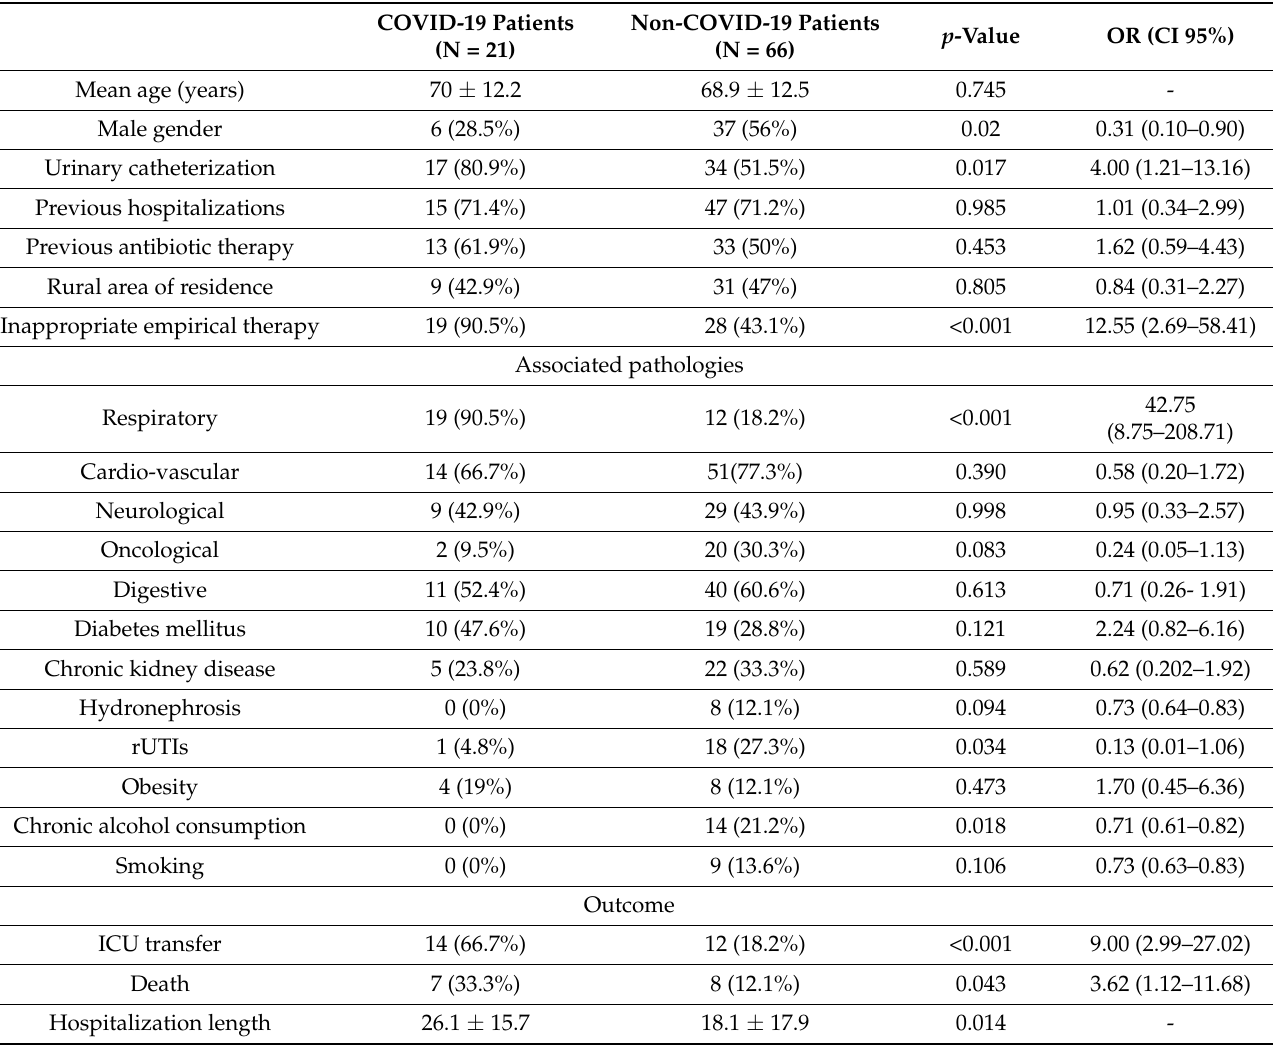
Table 1. Baseline characteristics of the study